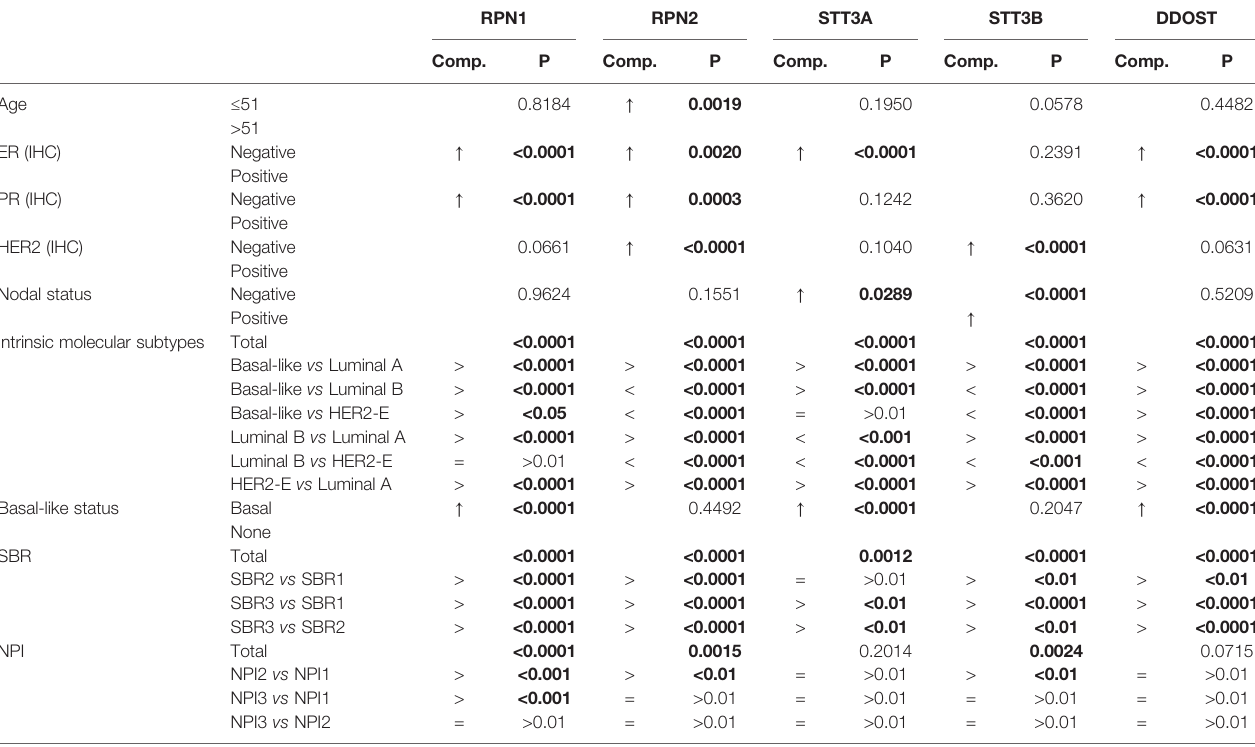
TABLE 1 | The relationship between the OST subunits and the clinicopathologic parameters of BC (bc-GenExMiner v4.5).